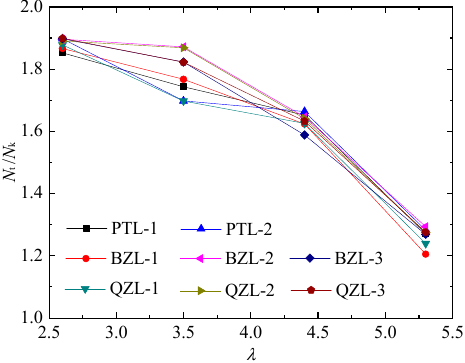
Figure 8. The relationship between N t / N k and λ .